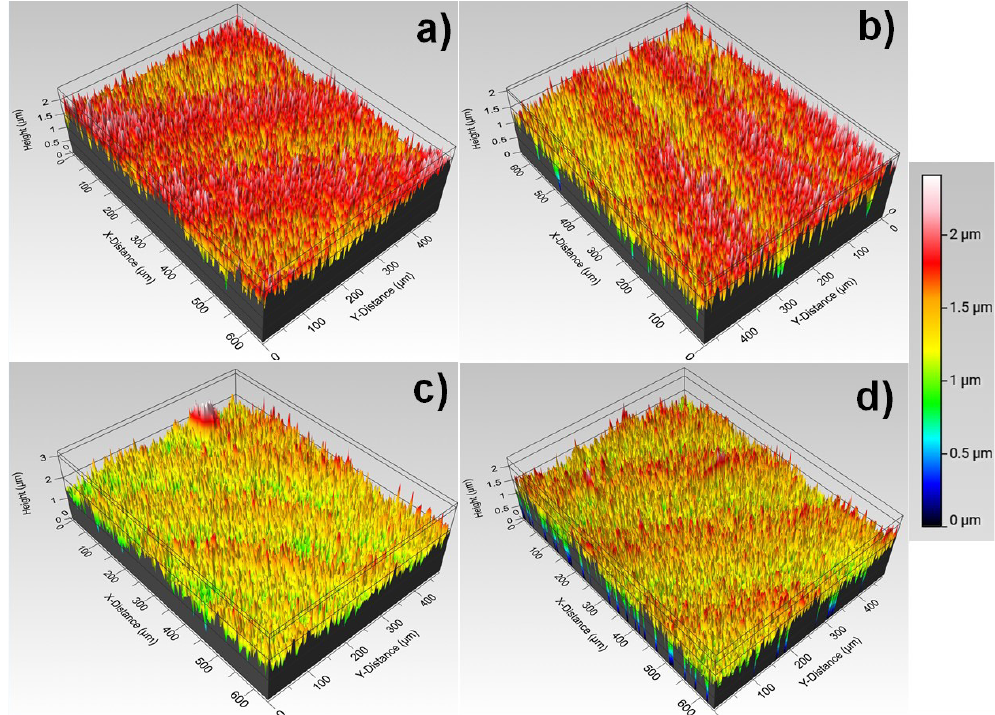
atmosphere (a) maraging 300 alloy and (b) maraging 350 2